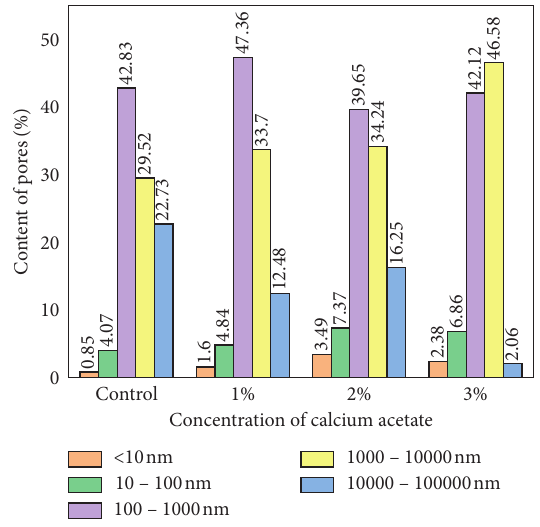
Figure 9: Content of pores in mortar